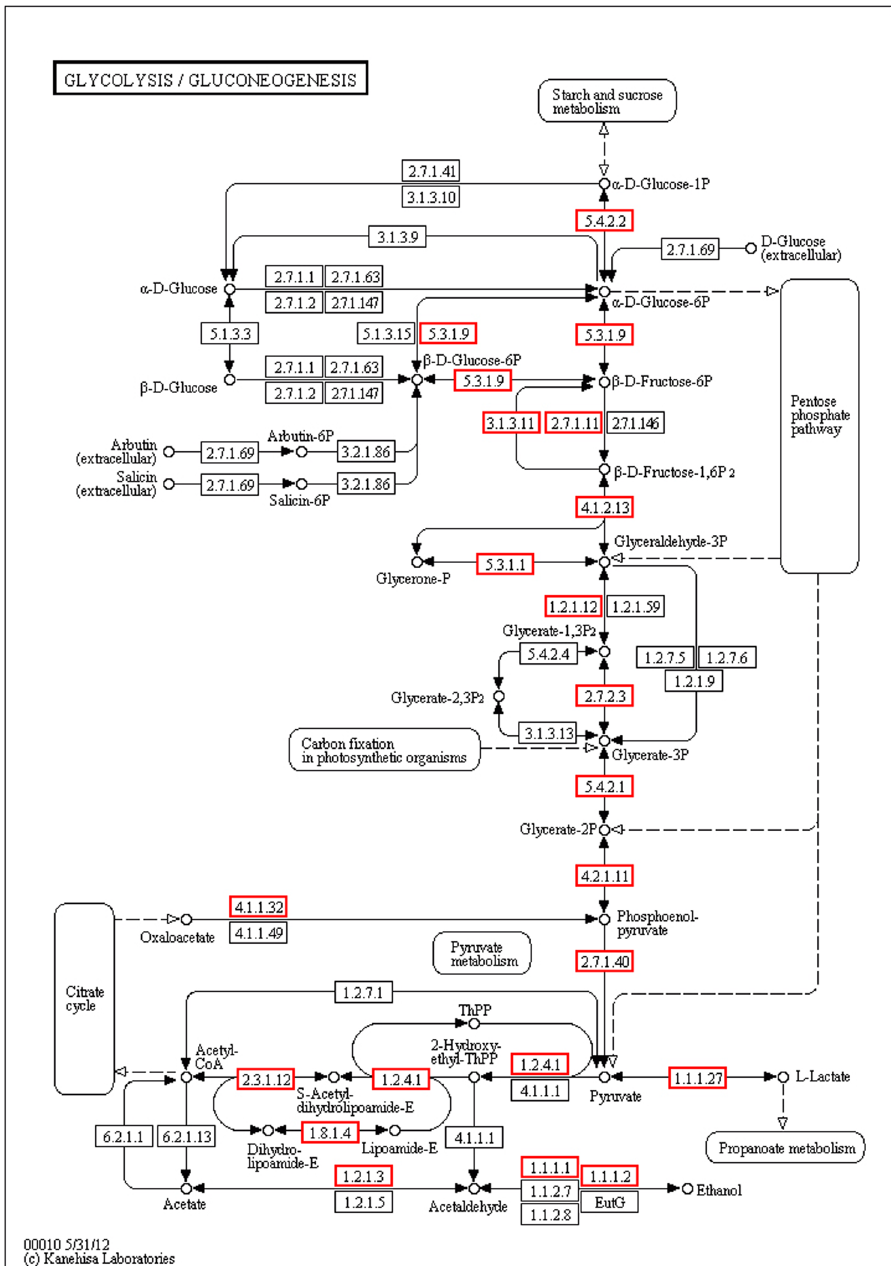
Figure 4. Glycolysis/Gluconeogenesis metabolic pathway. According to the KEGG analysis of DEPs, Gluconeogenesis was the most enriched pathway in this study. GAPDH and NAD binding were identified as “intersection DEPs”. Kanehisa, M., Furumichi, M., Tanabe, M., Sato, Y., Morishima, K. KEGG: new perspectives on genomes, pathways, diseases and drugs. Nucleic Acids Res. 45, D353–D361